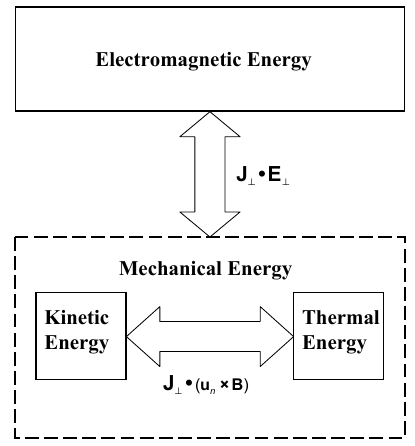
Fig. 2. Relationships of energy conversion among three types of energy in the